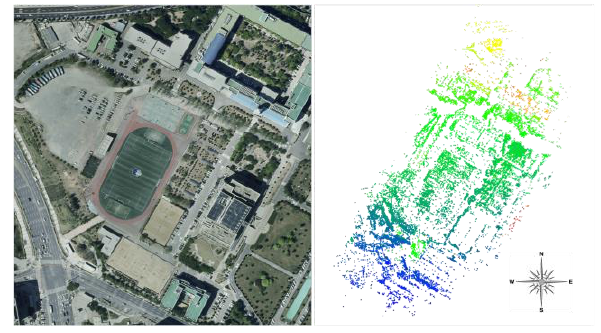
Figure 4. Example of a point cloud generated 2.2 Image Selection and Sorting for Mosaicking